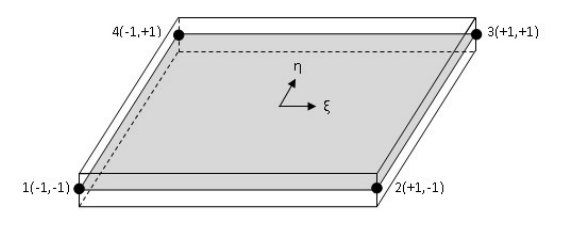
Figure 2: Shell parent element with a 4-noded reference